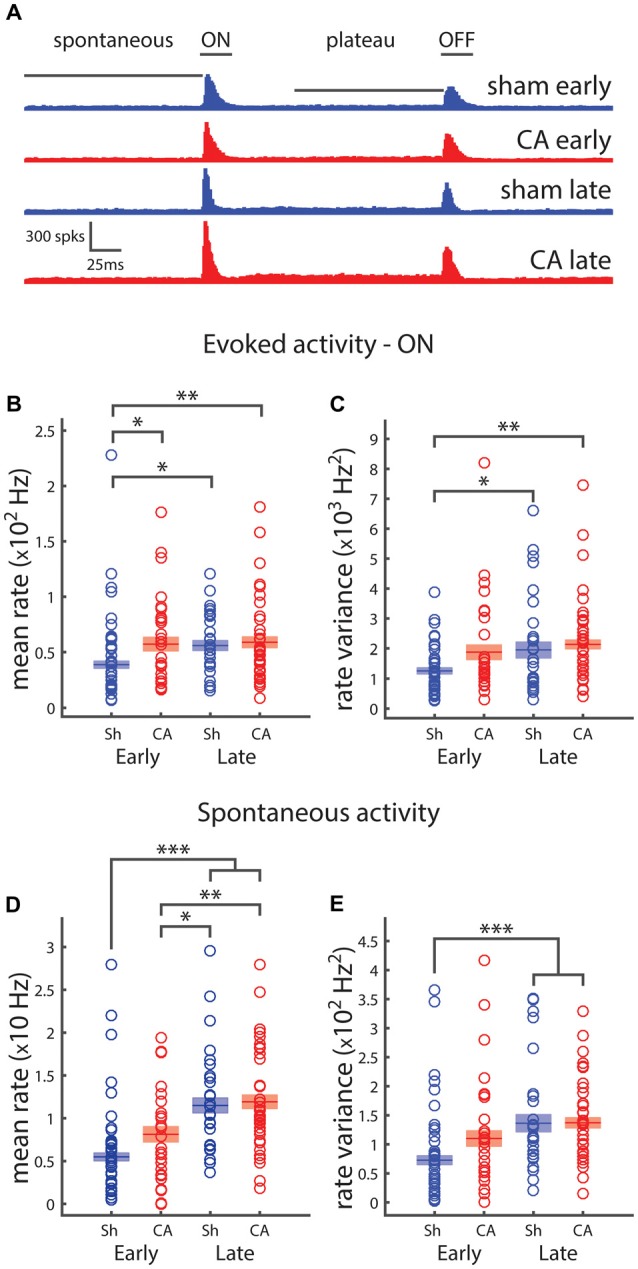
Spiking activity of thalamocortical neurons depends on development and is affected by ischemic injury. (A) The poststimulus time histogram (PSTH) for whisker ramp and hold deflection stimuli responses of sham (blue) and cardiac arrest (CA; red) neurons during early and late periods. The horizontal bars indicate the time periods over which spikes are counted for response counts in spontaneous, ON, plateau and OFF periods. (B) Average firing rates for evoked whisker deflection (onset: ON) response. Early sham responses are significantly smaller than all other group averages. (C) Average firing rate variance of whisker responses reveal that early sham responses are less variable than both late responses. (D) Firing rates during the 150 ms spontaneous period preceding deflection. Early sham and early CA firing rates are smaller than both late groups. (E) Firing rate variance of whisker responses reveals that early sham spontaneous activity is less variable that both late groups. Horizontal bars and rectangular shaded regions in (B–E) indicate mean ± S.E.M. of the α-trimmed data sets. *Indicates p < 0.05, **indicates p < 0.01 and ***indicates p < 0.001.